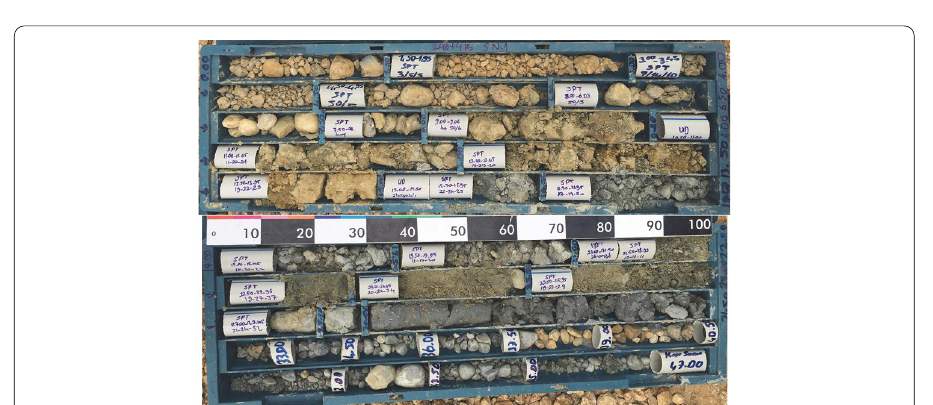
Fig. 4 Core box photographs from SK-246